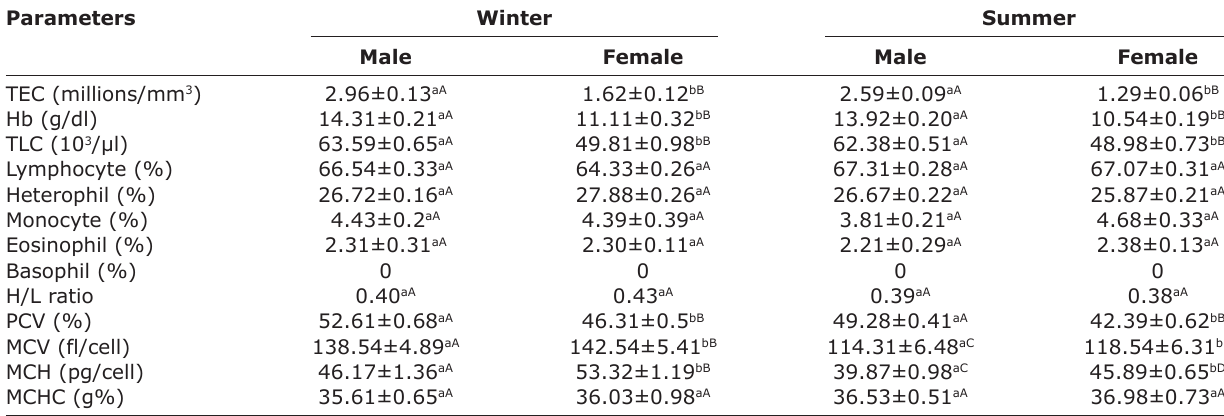
Table-3: Blood hematological parameters of male and female Vanaraja chickens during summer and winter season.